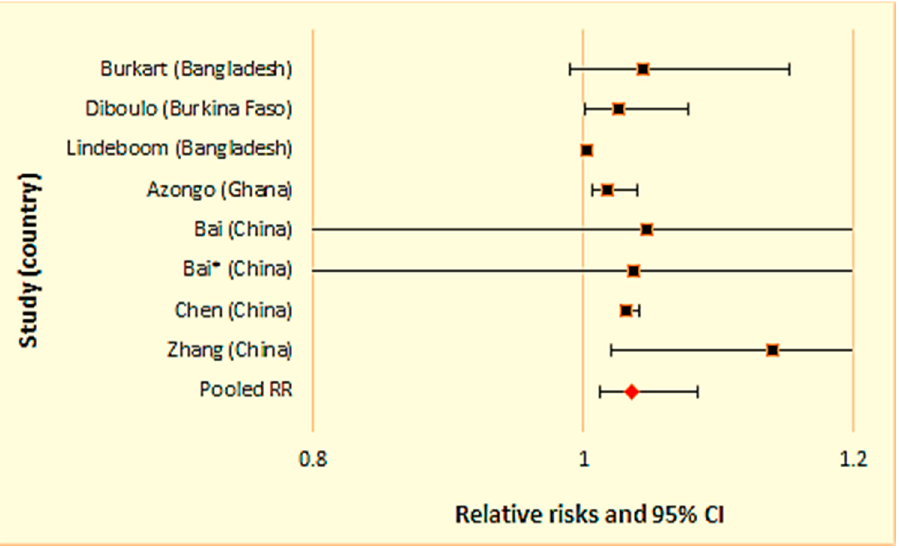
Figure 5. Sensitivity analysis for studies conducted in developing countries. Table 4. Effect size estimates of studies in developing countries.